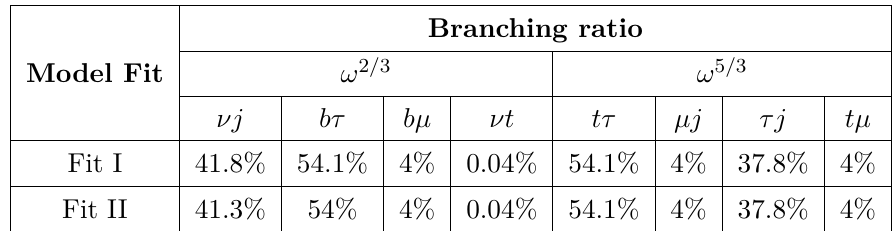
Figure 7 . Summary of the updated direct limits from LQ pair-production searches at the LHC for different quark-lepton decay channels of the R 2 LQ. The branching ratio for a specific decay channel of the LQ as indicated in the figure is varied from 0 to 1, while the other decay channels not specified compensate for the missing branching ratios to add up to one. These limits are independent of the LQ Yukawa coupling.